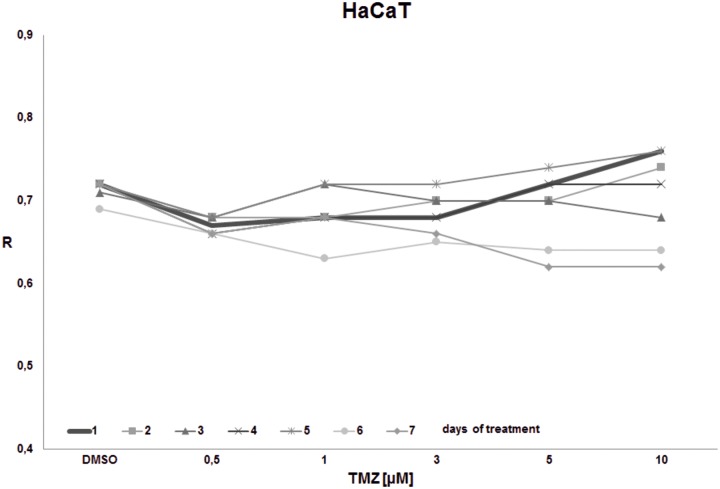
The impact of TMZ exposure period on DNA methylation in HaCaT cell line.HaCaT cell culture was treated with the given single dose of TMZ (0.5, 1, 3, 5, 10 μM) and left for 1–7 days. The global DNA methylation was estimated after 1st, 2nd, 3rd, 4th, 5th, and 7th day of incubation. No significant change in DNA methylation is observed during time.